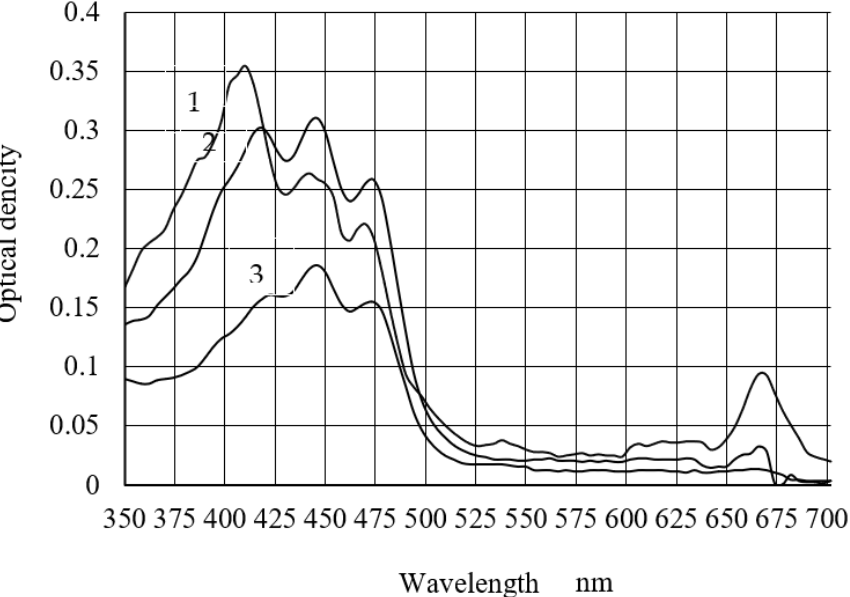
Figure 7. Influence of the KOH cconcentration during the saponification of carotenoids with alkali (KOH) on the spectral profiles of microalgae pigments. 1, 0.05 M; 2, 0.2 M; 3, 0.5 M.